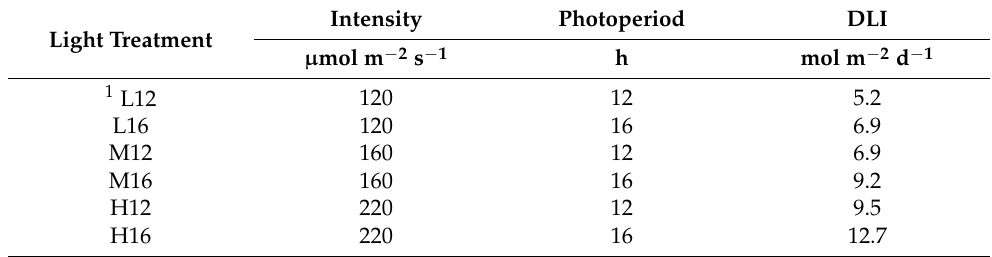
Table 1. Details of the treatments applied to the beet microgreens under the indoor system. Light Treatment